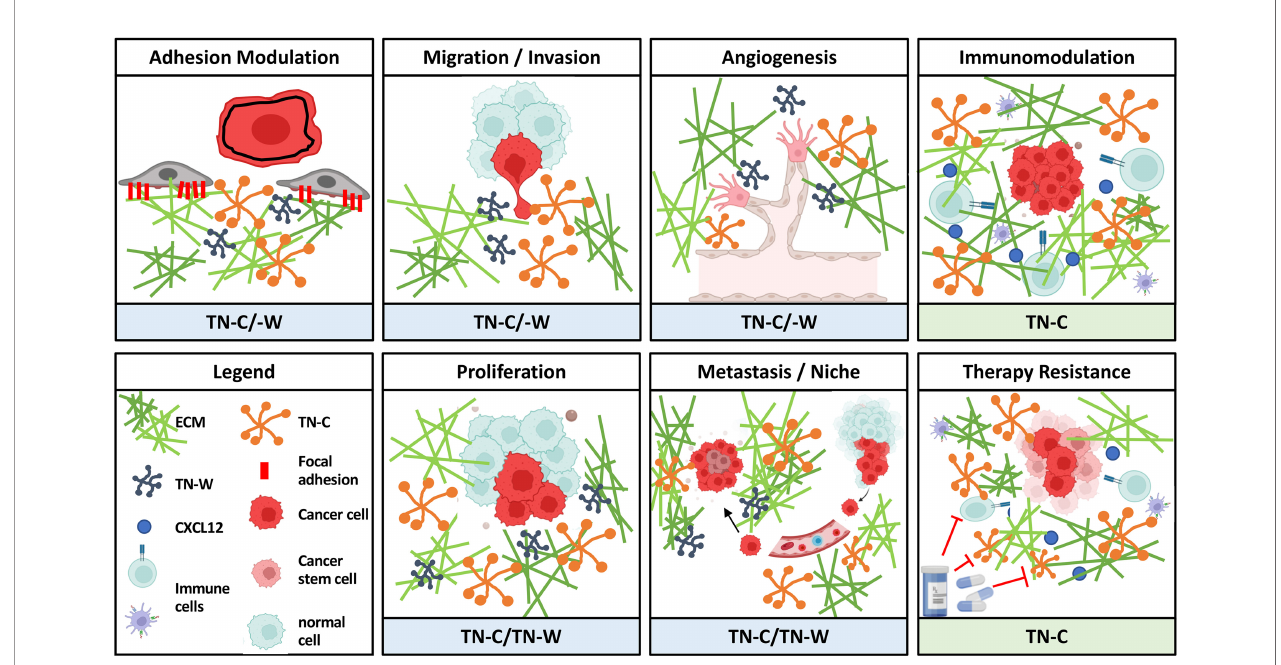
FIGURE 3 | Overview of oncogenic activities of TN-C and TN-W. As matricellular proteins, TN-C and TN-W can in fl uence various cellular processes involved in tumor progression by modulating the interplay between stromal and epithelial cells or other cells. Schemes were created using